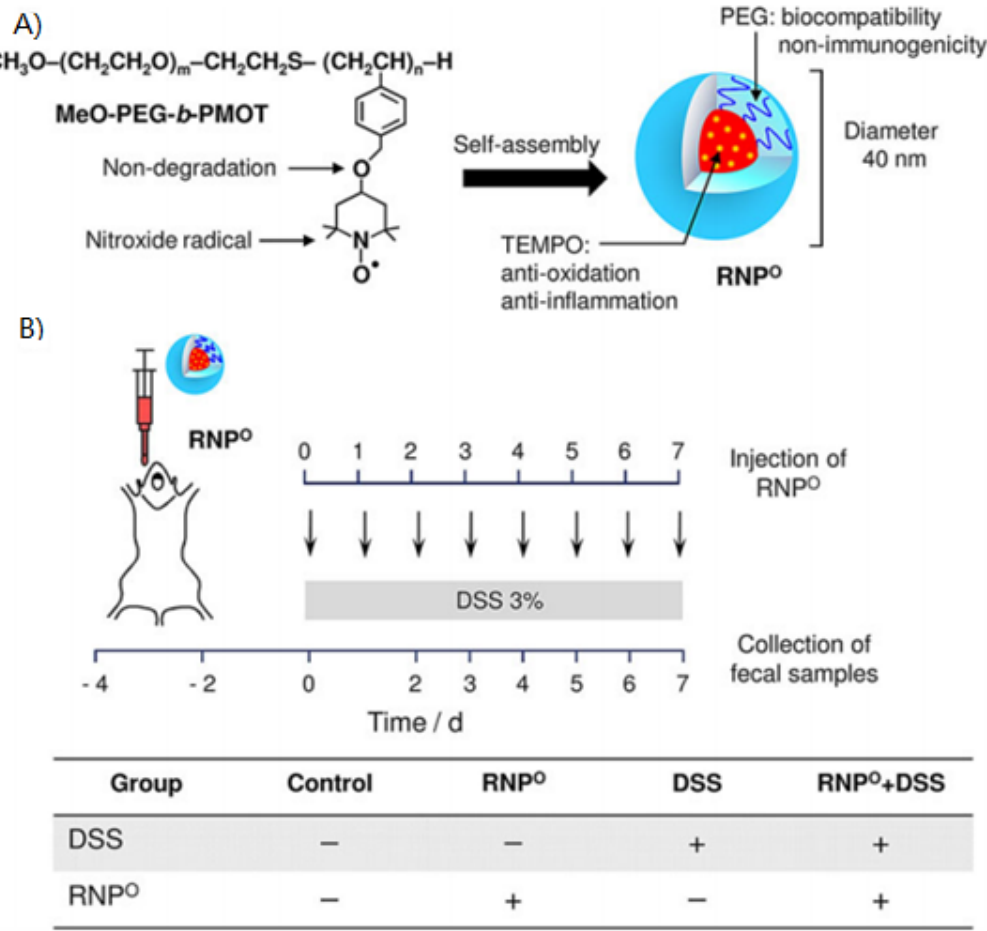
Figure 1. Schematic illustration of the redox nanoparticle, nitroxide radical-containing nanoparticles (RNPO) and the experimental design. ( A ) RNPO was prepared using a self-assembling amphiphilic block copolymer (MeO-PEG-b-PMOT) composed of a hydrophilic PEG segment and a hydrophobic poly(4-methylstyrene) segment possessing 2,2,6,6-tetramethylpiperidine-1-oxyl (TEMPO) moieties via ether linkage. ( B ) Murine colitis was induced by supplementation of 3% (wt/vol) dextran sodium sulfate (DSS) in the drinking water for 7 days and RNPO (166.7 mg/kg) was orally administered daily during the 7 days of DSS treatment. The animals were divided into four groups, n = 5 mice per group. Reprinted with permission from [8].